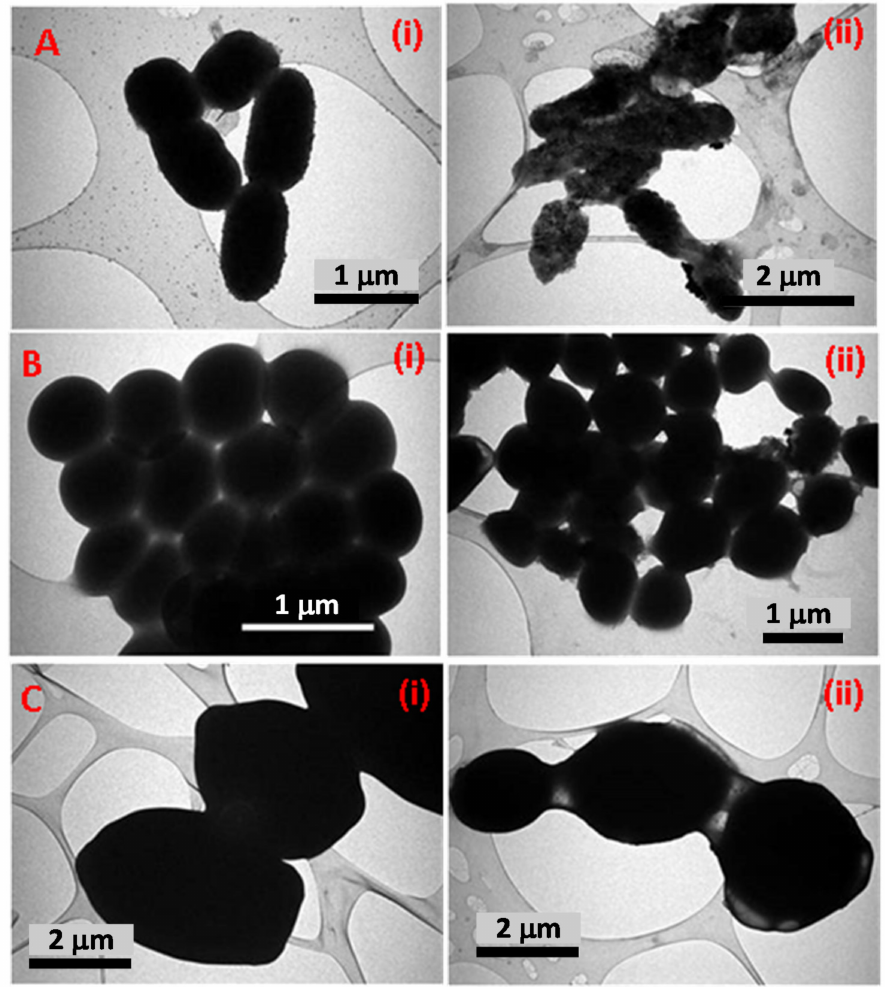
Figure 9. Shows a TEM-based comparative analysis of the interaction of TCE-Ag-3 NPs with test microbial cells. Panels ( i ) in ( A – C ) show TEM images of untreated MDR-PA, MRSA, and C. albicans cells, whereas panels ( ii ) in ( A – C ) show TEM images of MDR-PA, MRSA, and C. albicans cells treated with their MIC of TCE-Ag-3 NPs after 24